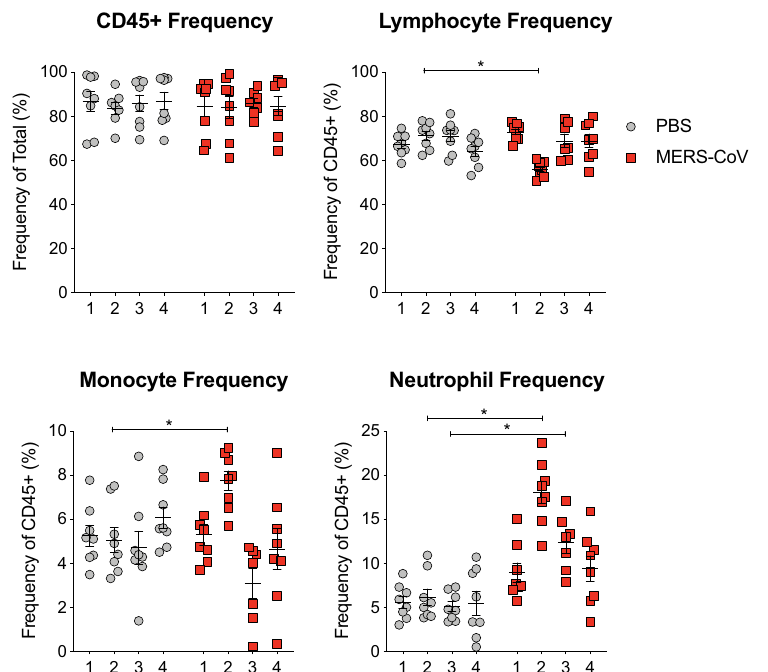
Fig 3. Corroboration of VetScan data by flow cytometry. Whole peripheral blood from mock or MERS-CoV infected mice was stained and analyzed by flow cytometry from two independent experiments and the data was combined. Total white blood cells were identified by cell surface marker CD45. Lymphocyte frequency was generated by combining the frequencies of T, B, NK and NK-T cells. Monocytes and neutrophils were identified by CD115 and Ly6G, respectively. The line is at the mean and the error bars represent the standard error of the mean. Each data point represents the data from one mouse. Asterisks denote statistical significance (P < 0.05) as determined by two-way ANOVA and Sidek’s multiple comparison